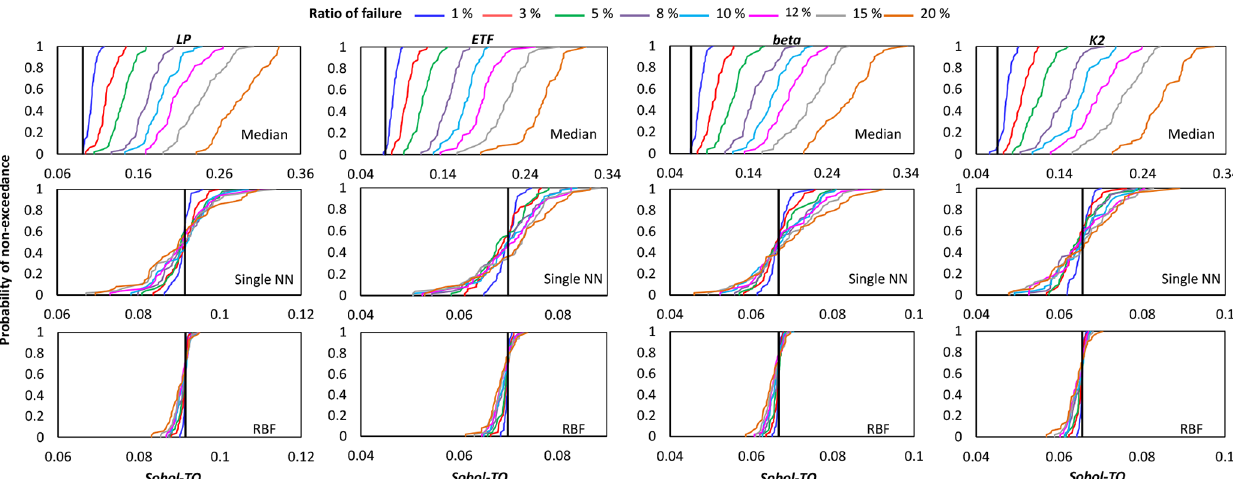
Figure B3. Comparison of the proposed crash-handling strategies in a sensitivity analysis of the HBV-SASK model using the variance-based algorithm for different ratios of failure. The CDFs of the sensitivity indices for weakly influential parameters ( LP , ETF , beta , K2 ) are shown in this plot. The vertical line (solid black) on each subplot represents the corresponding “true” sensitivity index obtained when there were no